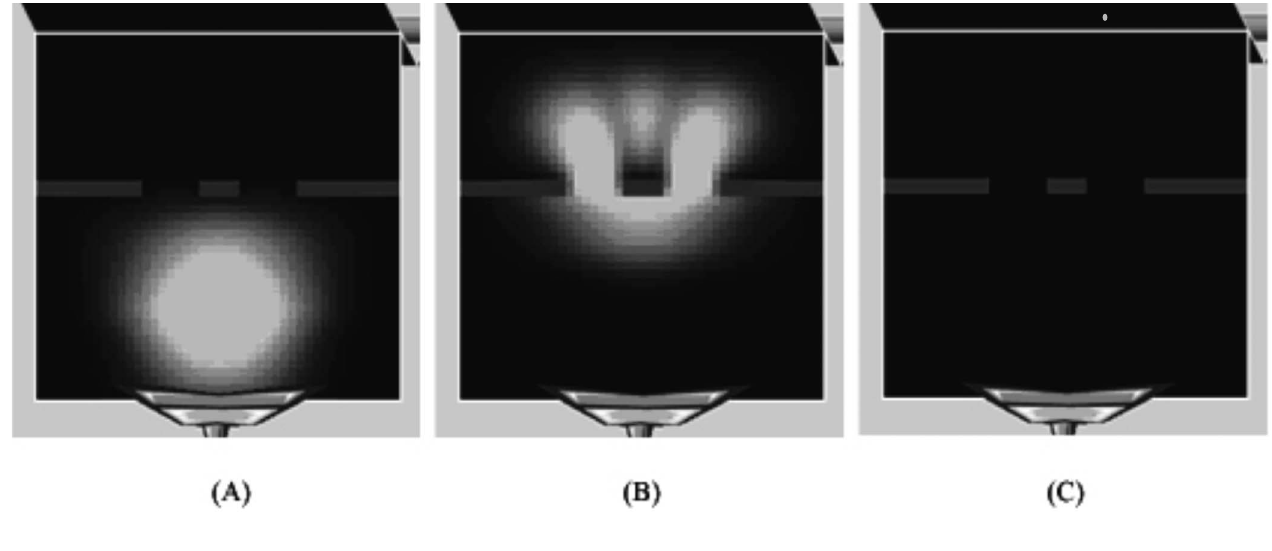
FIG. 5. A sequence of screenshots from the Quantum Wave Interference